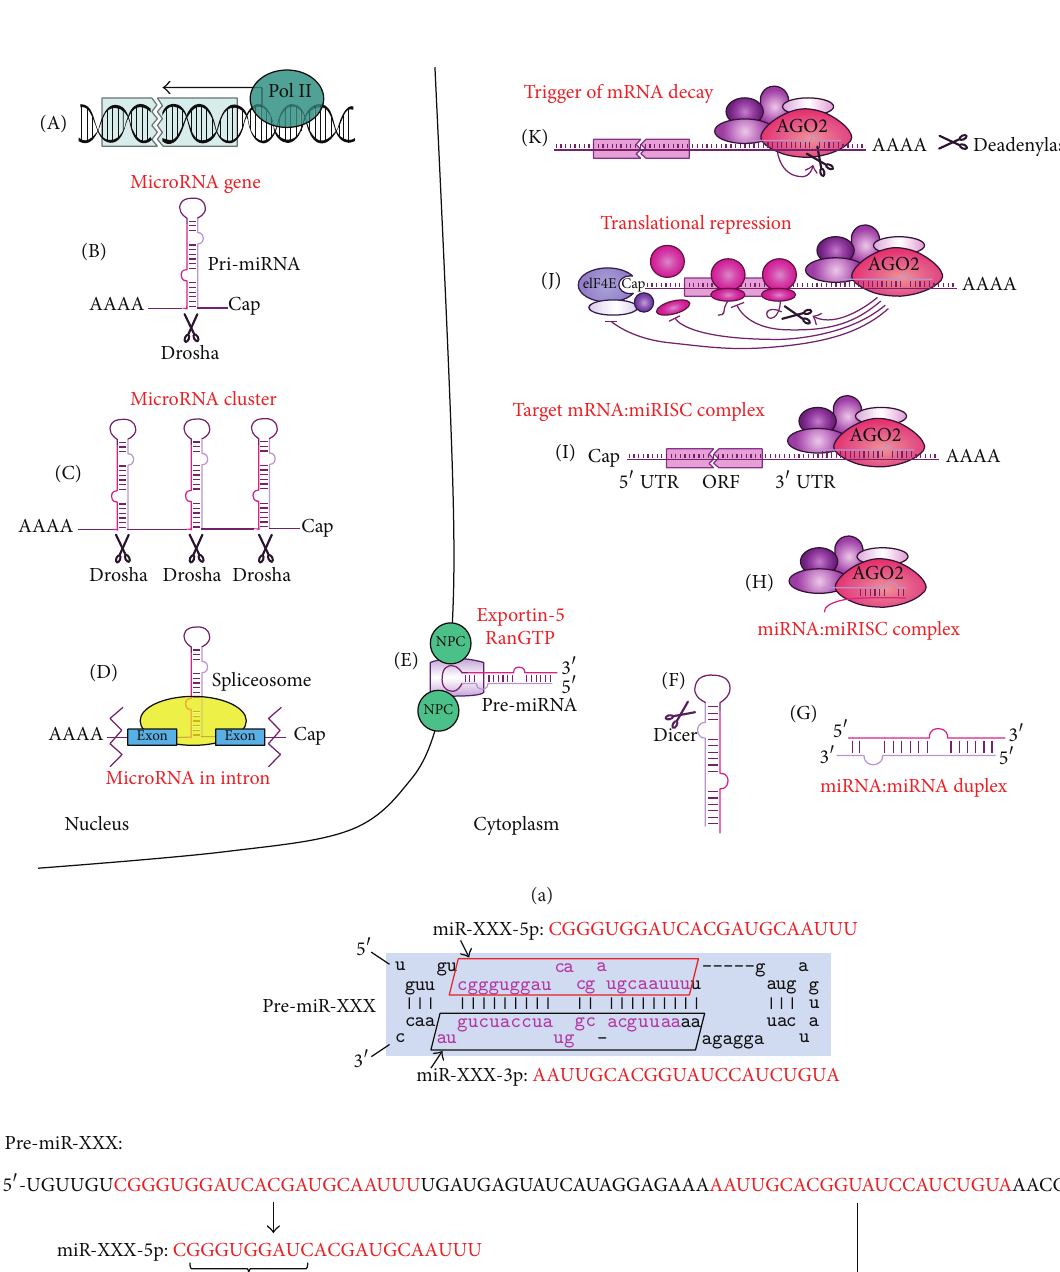
Figure 1: Biogenesis and mechanism of action of miRNAs. (a) miRNAs are transcribed mainly by polymerase II (A) from a gene encoding a single miRNA (B), or from a polycistronic gene (C), or from a gene in an intronic region (D). Resulting pri-miRNAs are processed by type III RNase Drosha. The newly formed stem-loop structure, pre-miRNA, is recognized by the XPO5, RanGTP complex, and is transported to the cytoplasm by exportin-5 (E). Dicer cleaves the loop (F), leaving a double-stranded fragment, the miRNA-3p:miRNA-5p duplex (G). The duplex is then unwound and loaded into the miRISC complex (H) where it recognizes and anneals to the UTR of mRNA target (I). The messenger RNA:miRISC complex mediates translational repression (J) or mRNA decay (K). (b) Processing of a pre-miRNA gives rise to two mature miRNAs named miR-XXX-3p and miR-XXX-5p where miR-XXX-3p miRNA originates from 3 󸀠 -end and miR-XXX-5p miRNA originates from 5 󸀠 -end of the